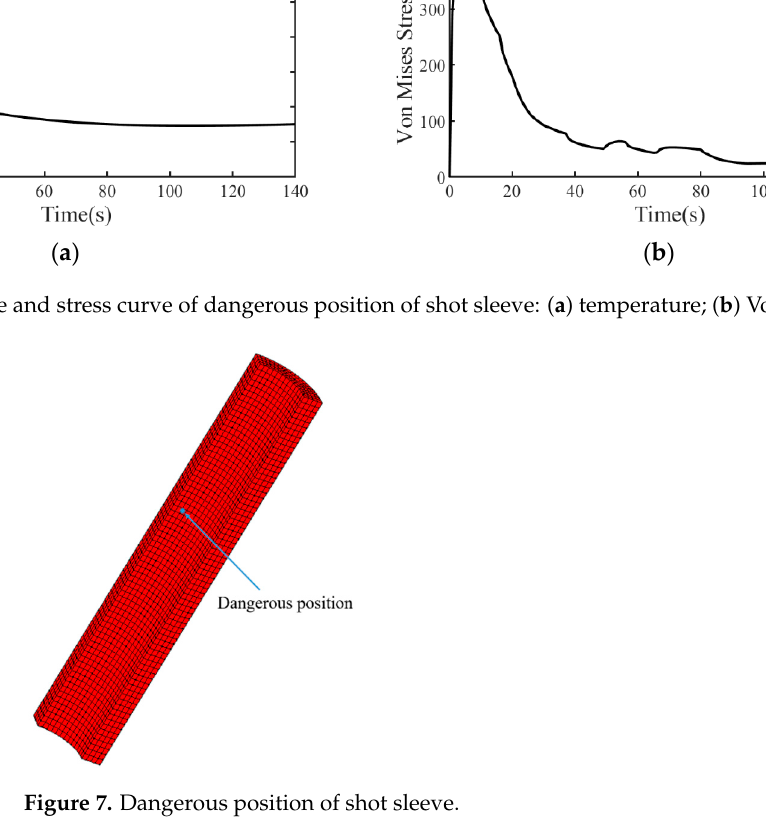
Table 2. Sample points and corresponding response values of training